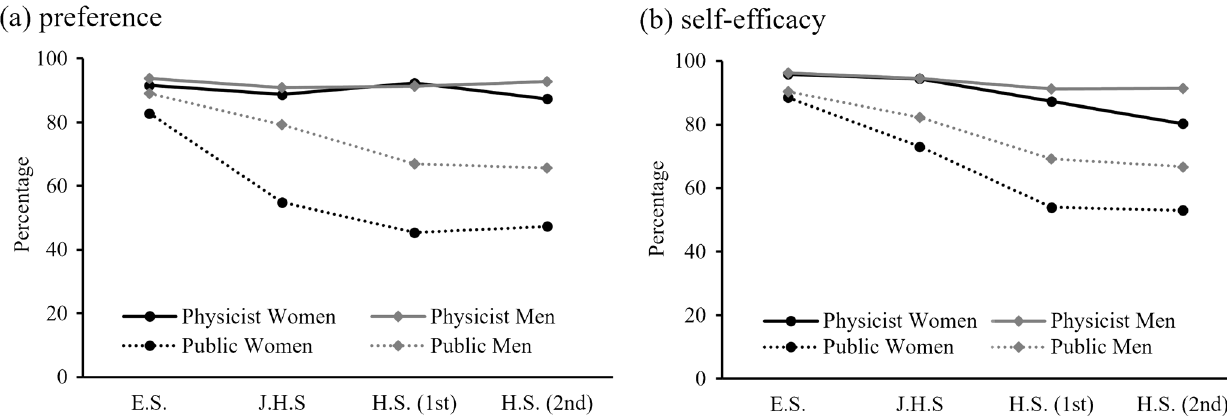
FIG. 1. Percentage of preferences (a) and self-efficacy (b) for physics from elementary school to the second year of high school. The numbers shown are the percentage of the sum of like and probably like in the total of like, probably like, dislike, and probably dislike (a), and the percentage of the sum of I can perform and I probably can perform in the total of I can perform, I probably can perform, I can ’ t perform, and I probably can ’ t perform (b). E : S : ¼ elementary school, J : H : S : ¼ junior ð 1 st Þ ¼ first high school, H.S. year of high school, H.S. ð 2 nd Þ ¼ second year of high